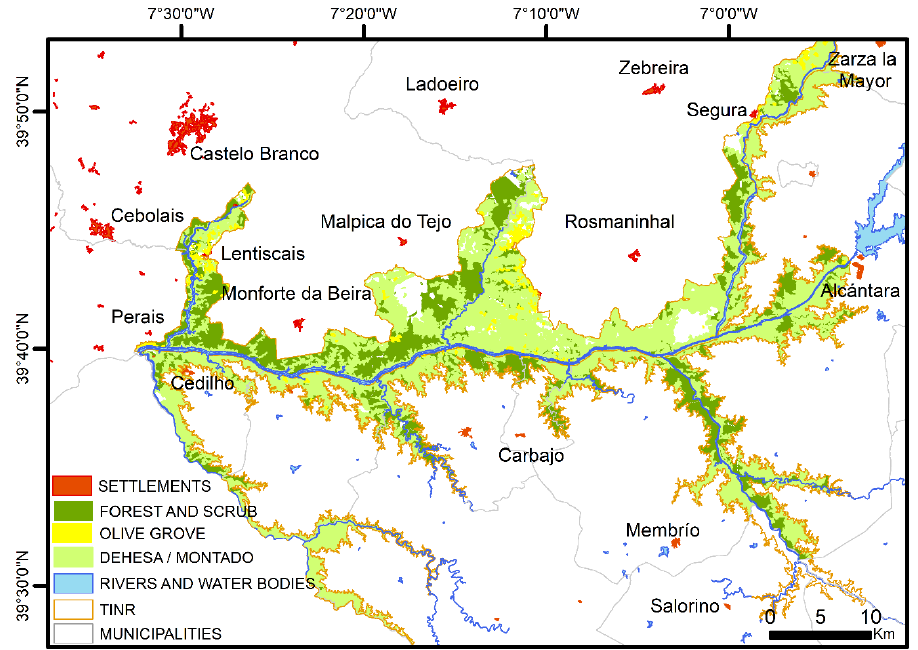
Figure 3. Main land uses of soil in TINR. Source : Authors’ own elaboration based on COS and SIOSE data.